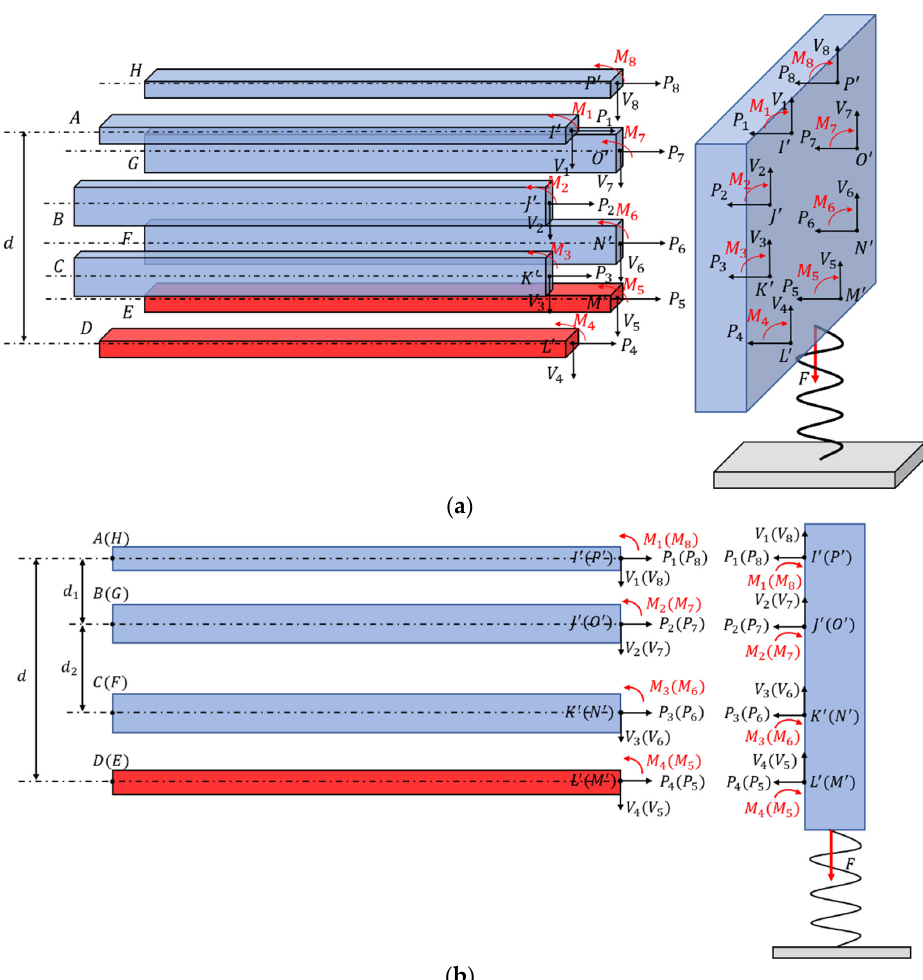
Figure 5. Free-body diagram used in determining the bending moment, axial force, and the shear force acting on the beams: ( a ) the general view; ( b ) the front view.